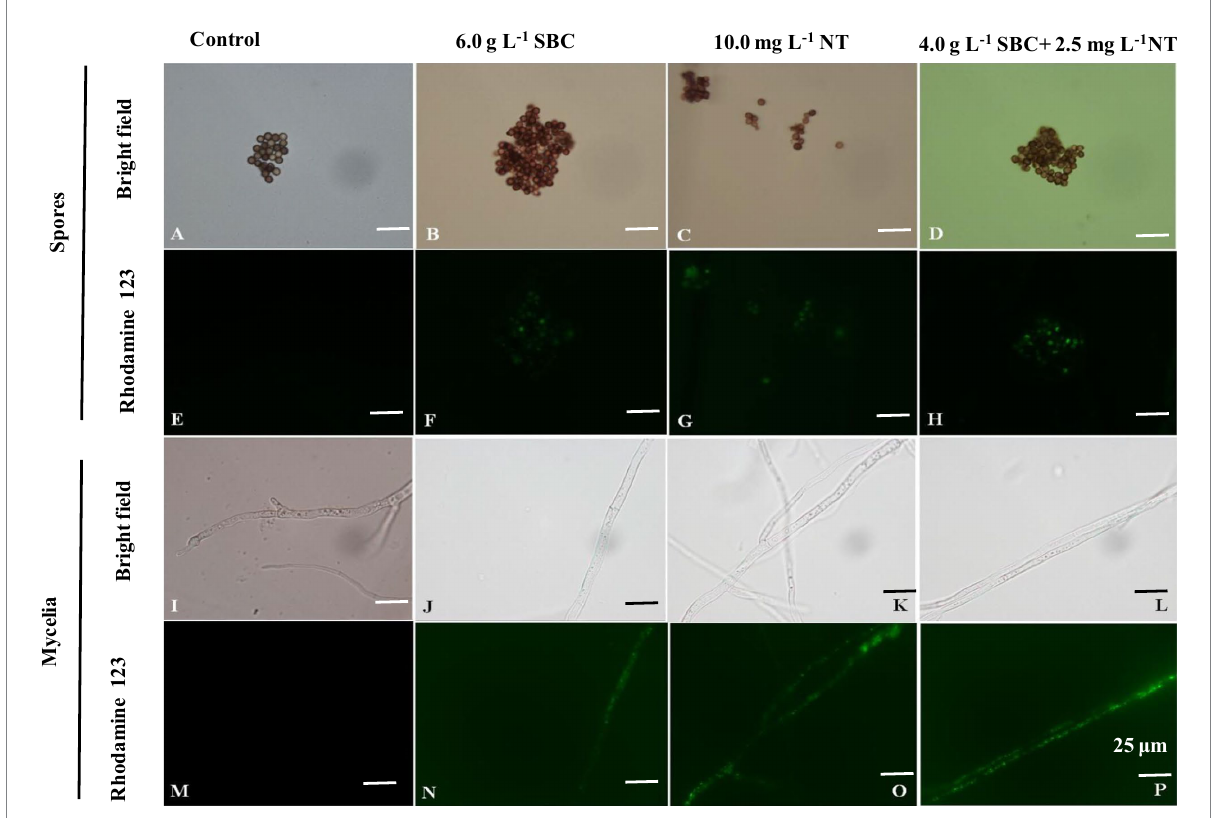
FIGURE 11 Aspergillus niger stained with Rhodamine 123 after treatment with SBC or NT. (A,E) Spores in the control; (B,F) spores treated with 6.0 g/L SBC; (C,G) spores treated with 10.0 mg/L NT; (D,H) spores treated with 4.0 g/L SBC + 2.5 mg/L NT; (I,M) mycelia in control; (J,N) mycelia treated with 6.0 g/L SBC; (K,O) mycelia treated with 10.0 mg/L NT; (L,P) mycelia treated with 4.0 g/L SBC + 2.5 mg/L NT mycelia. Images were obtained by microscopy at 1,000× magnification, bar = 25 μ